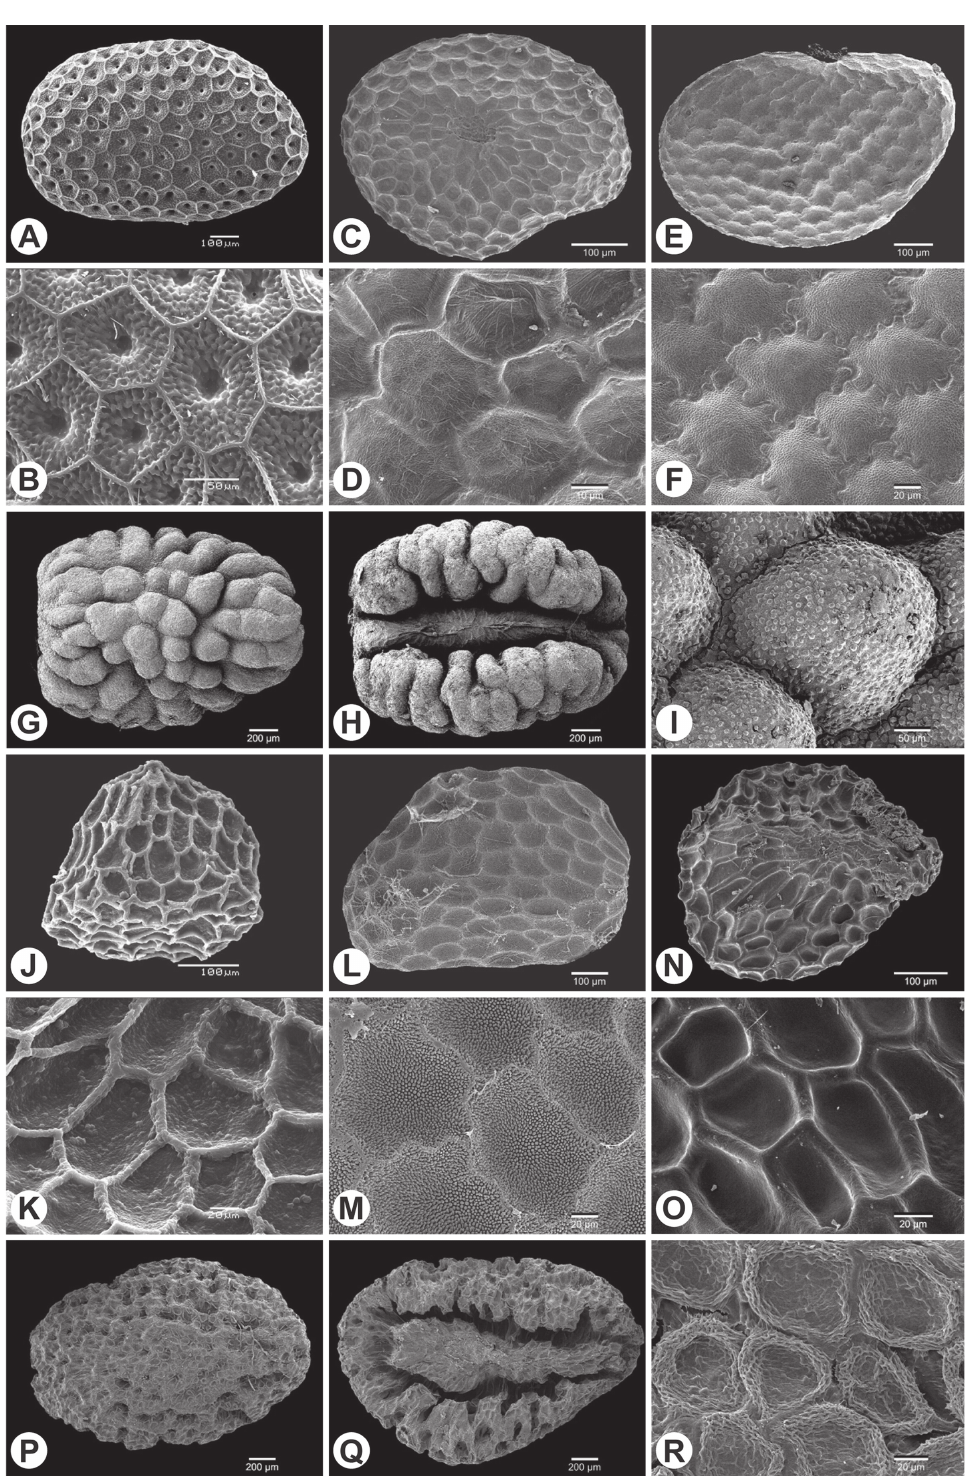
Fig. 5. Scanning electron microscopy micrographs of seeds and a detail of their surface. A–B . Astiella antsalovansis Groeninckx sp. nov. C–D . A. deblockiae Groeninckx sp. nov. E–F . A. desseinii